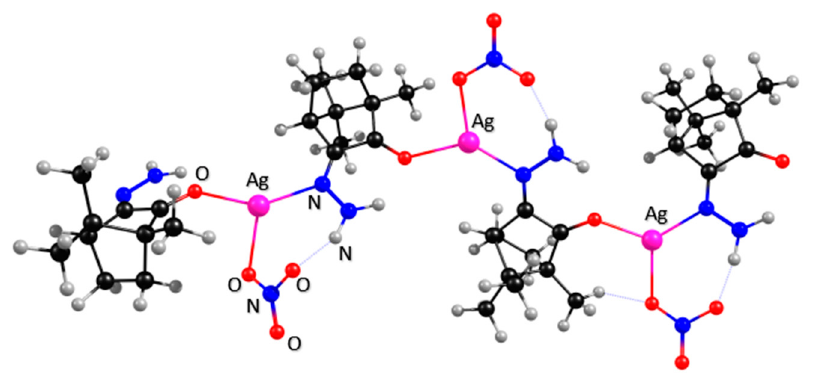
Figure 3. Calculated structural arrangement of [Ag(NO 3 )(OC 10 H 14 NNH 2 )] ( 1a ) showing hydrogen bonding between the camphor imine substituent (Y = NH 2 ) and the nitrate (NO 3- ) co-ligand.